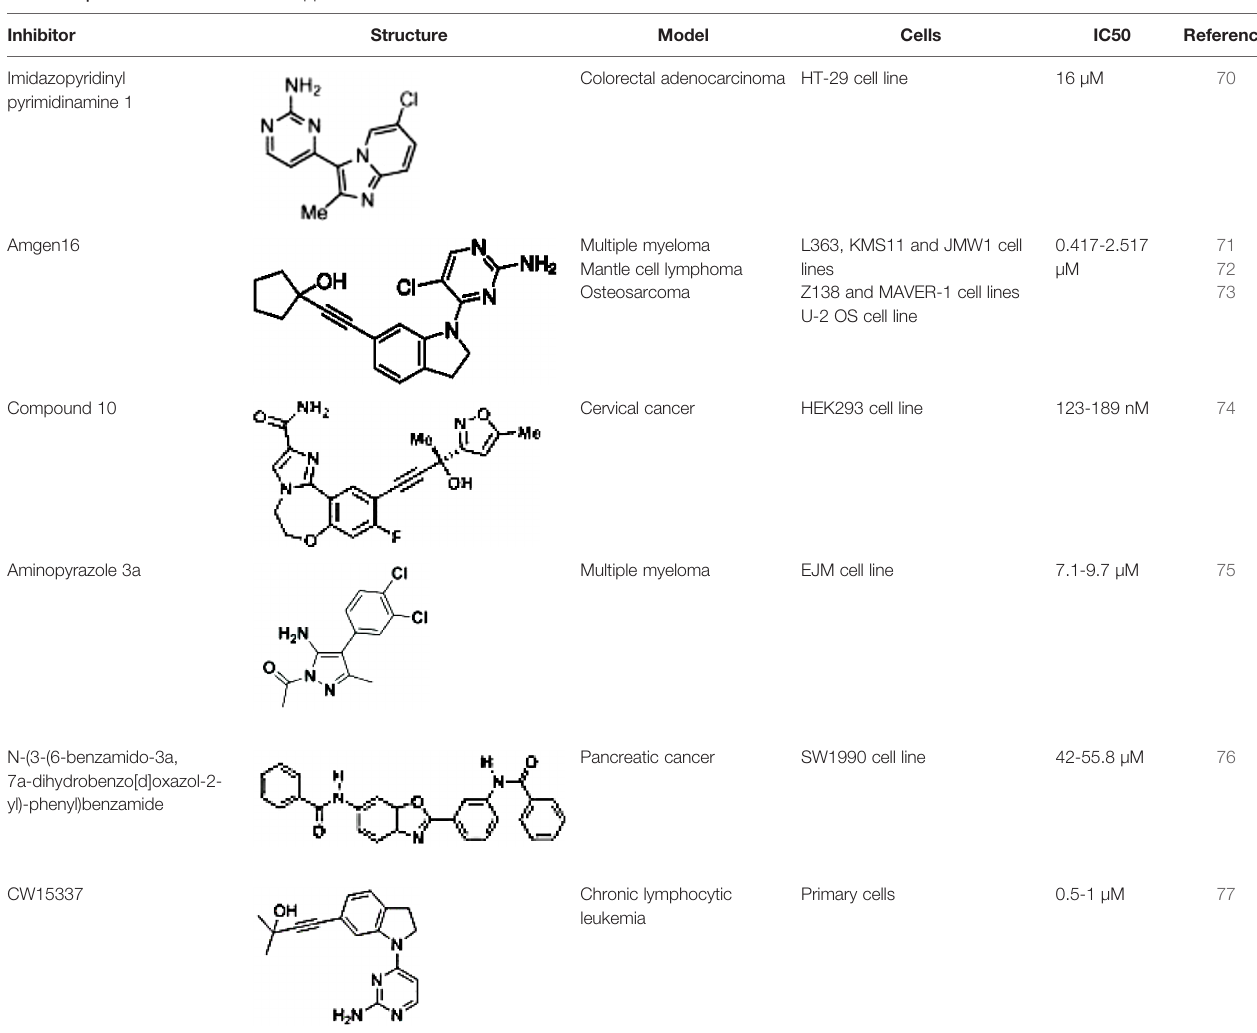
TABLE 1 | Overview of NIK inhibitors applied in vitro .